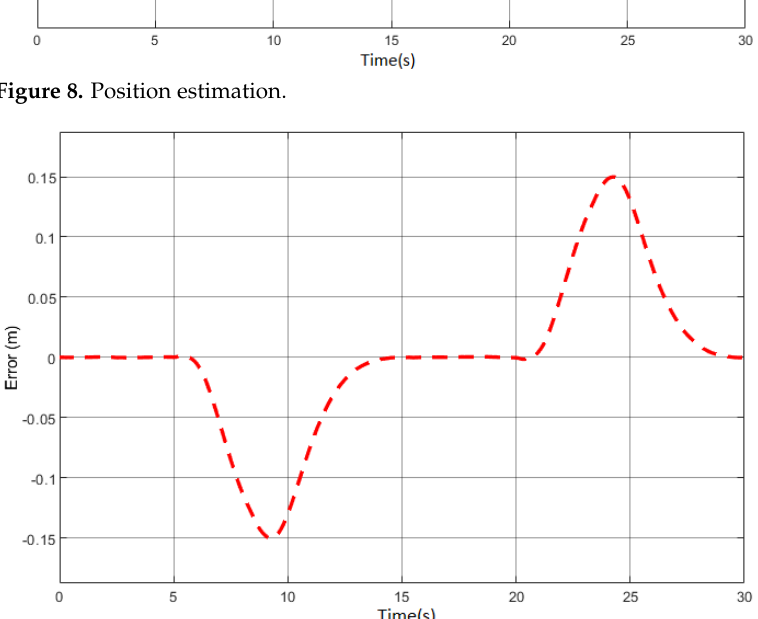
Figure 9. Position